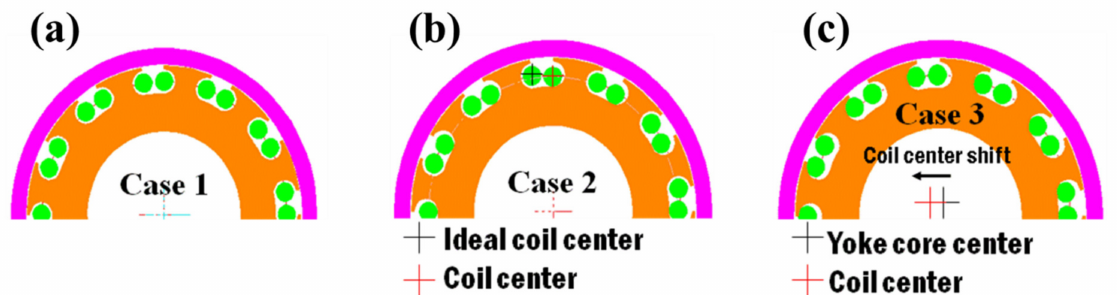
Figure 4. Magnetization yoke design for ( a ) when the yoke center and coil center coincide; ( b ) when the center of the winding coil has a 100 µ m deviation; ( c ) when the center of the winding coil has a 50 µ m shift from the center of the yoke core.